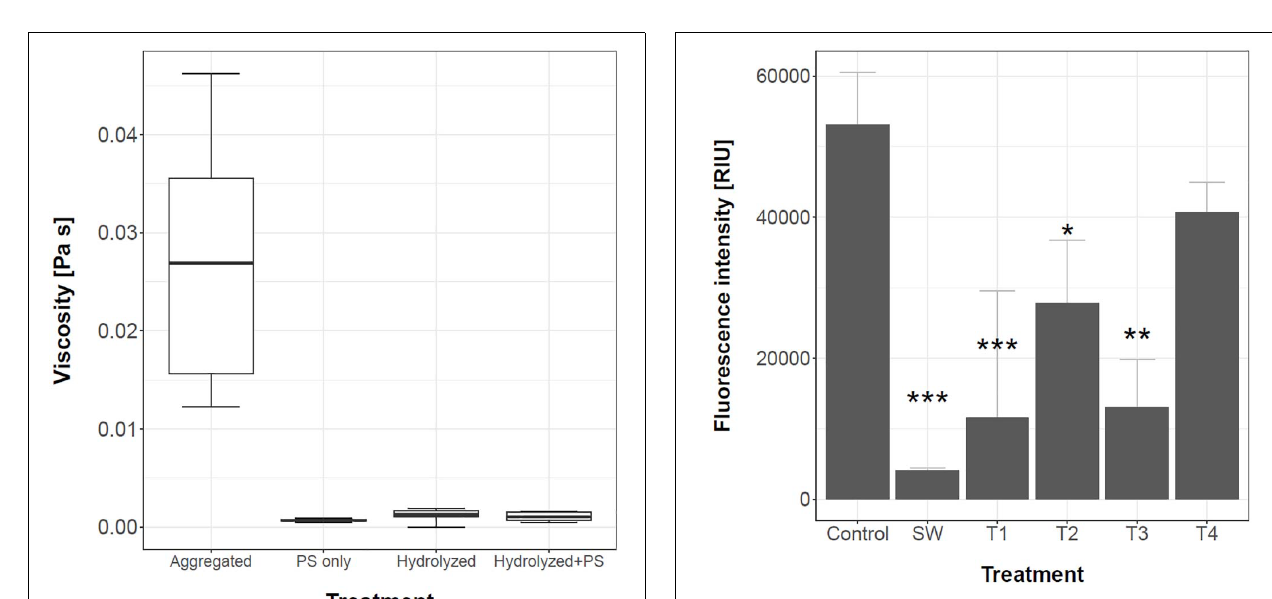
FIGURE 9 | Residual fluorescence remained in the suspension after mucus samples were shear stressed. Control – PS microspheres added to seawater; SW – seawater without PS microspheres added; T1 – untreated mucus with PS microspheres; T2 – vortex treated for 20 s; T3 – ultrasound homogenized for 10 s; T4 – ultrasound homogenized for 20 s. n = 3 for all treatments. Stars denote a significant difference between treatments and control; * ( p < 0.05); ** ( p < 0.01); *** ( p <